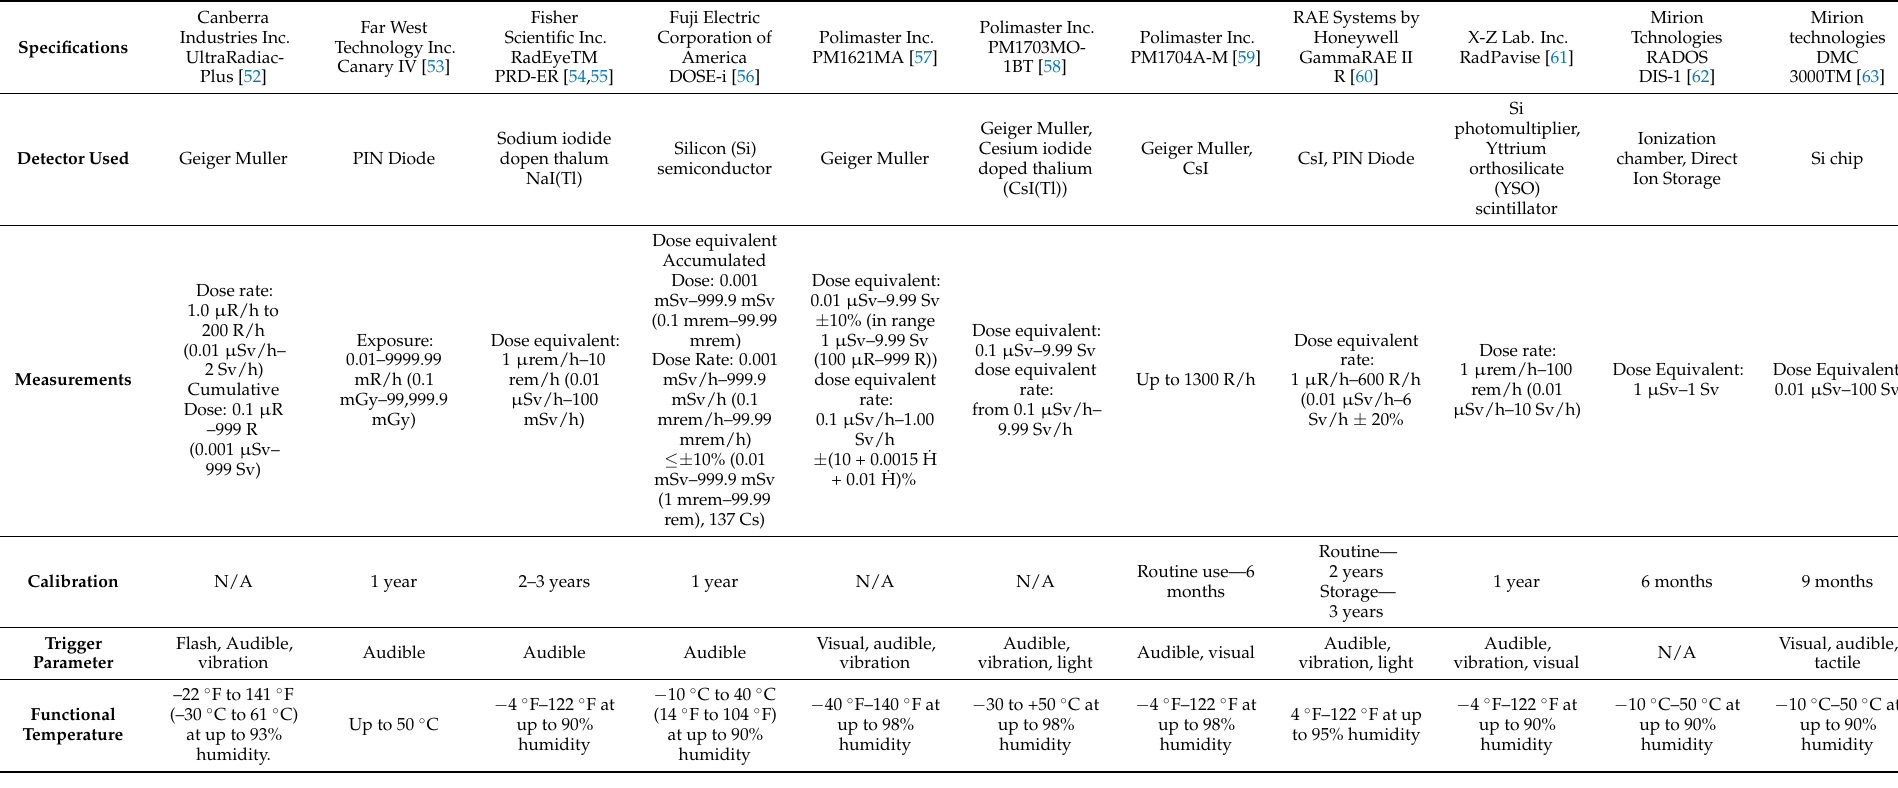
Table 2. Technical specification based on the commercial availability of radiation personal